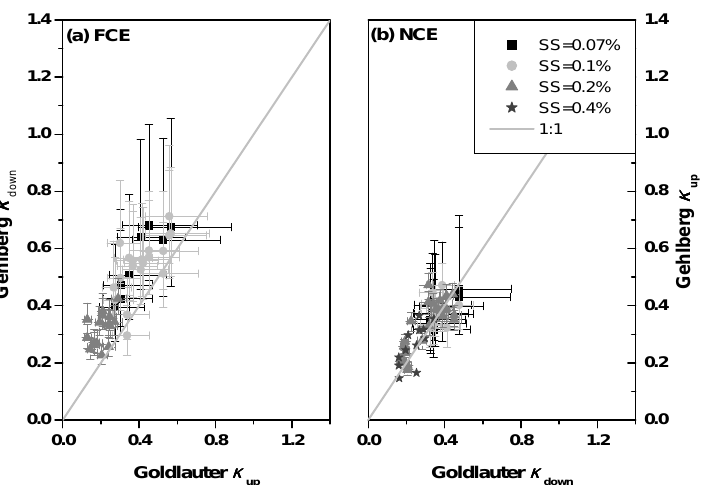
Fig. 6. Hygroscopicity parameter (cid:20) compared for up- and downwind station during the Full Cloud Events (FCE, Figure 6. Hygroscopicity parameter κ compared for the upwind and downwind stations during the full cloud events (FCE, left panel) and non-cloud events (NCE, right panel), as given in Fig. 3. However, the error bars are the 2.5 and 97.5% percentile limits for κ , produced by left panel) and Non Cloud Events (NCE, right panel) as given in Fig. 3. However, the error bars are the 2.5% 100000 Monte Carlo samples, and representing a confidence level of and 97.5% percentile limits for (cid:20) , produced by 100000 Monte Carlo samples, representing a confidence level of 95%.